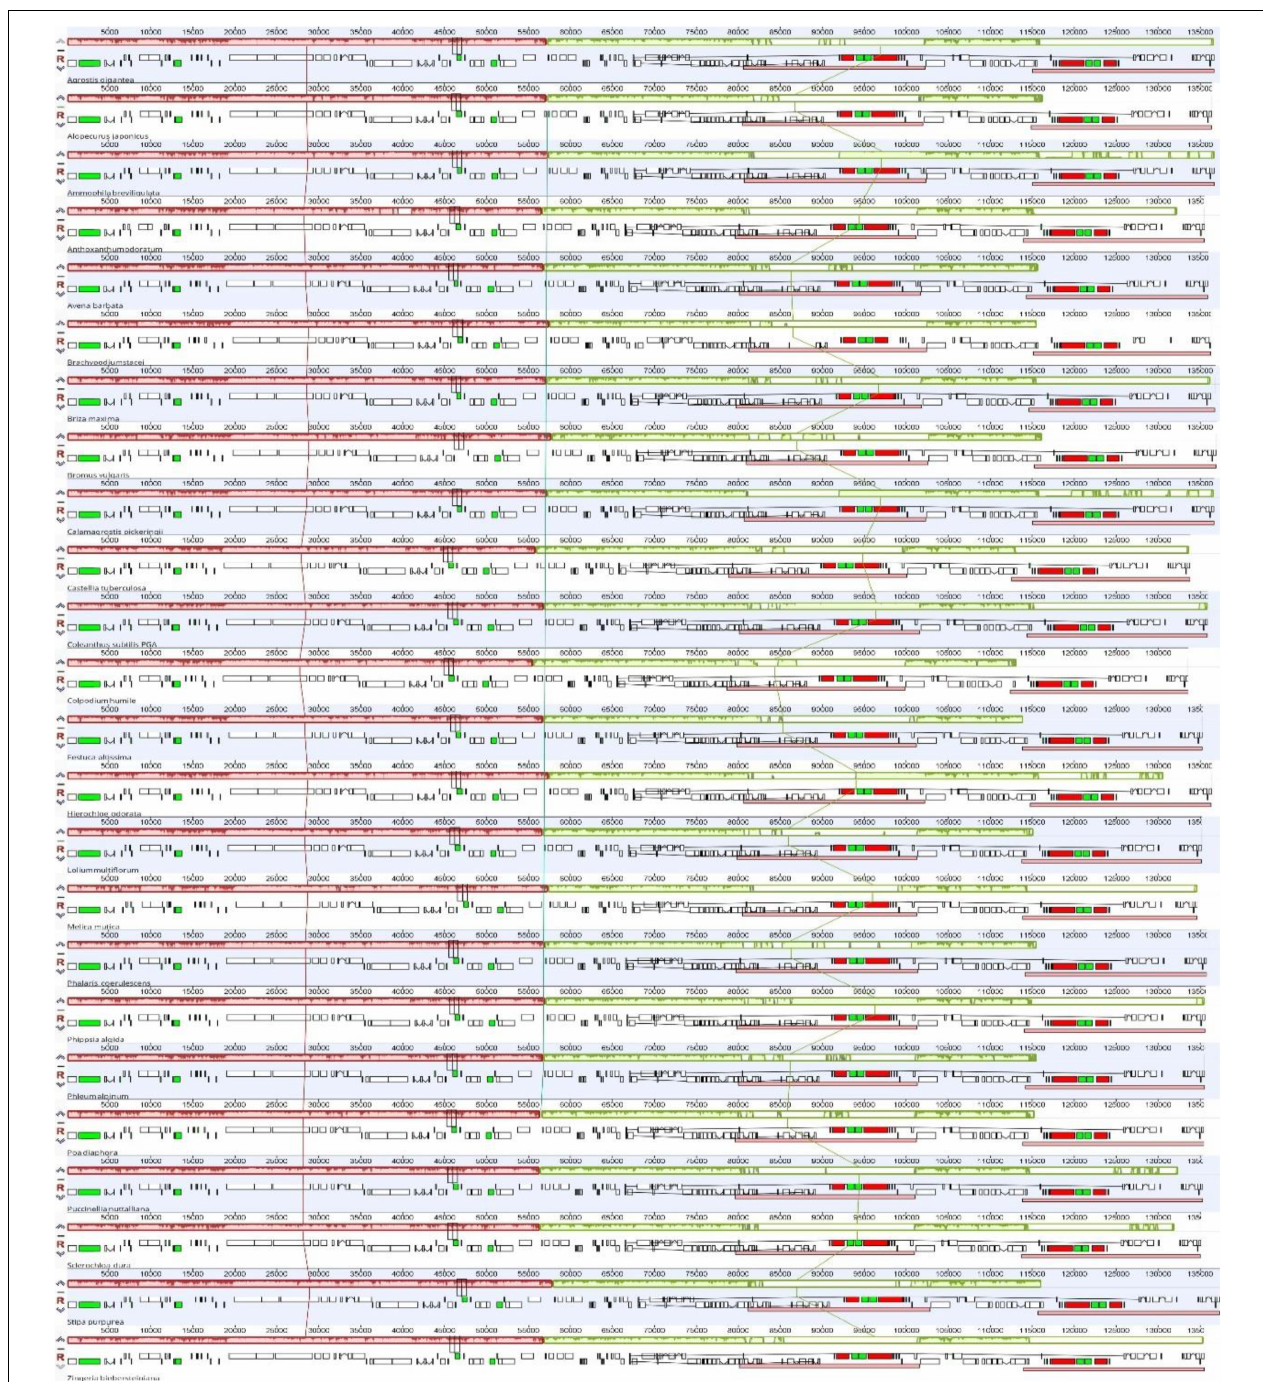
FIGURE 2 | Comparison of the chloroplast genome structures among 24 Poaceae species. The different colored squares represent different types of genes. Black represents transfer RNA (tRNA), or green if the tRNA has introns (rRNA). Red represents ribosomal RNA, while white represents protein coding genes